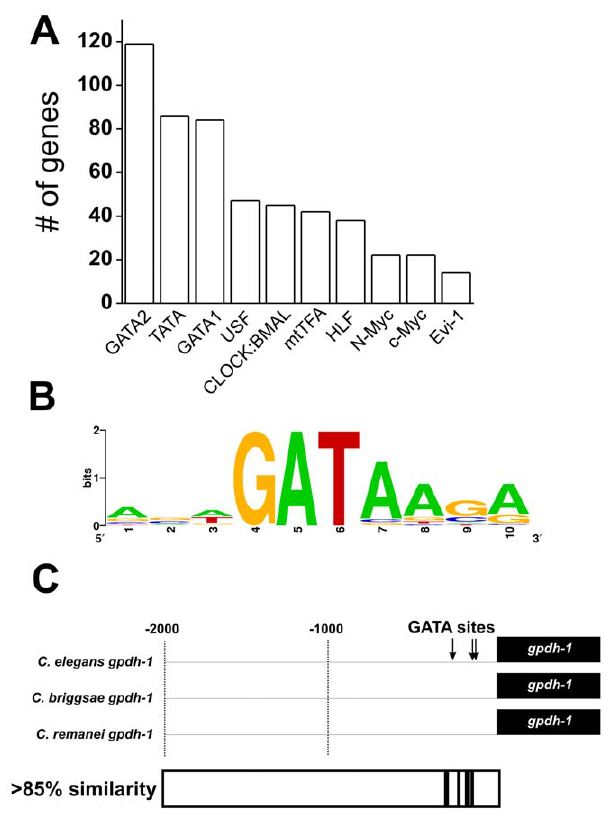
Figure 3. GATA transcription factor binding sites are over- represented among upregulated ORGs. (A) TRANSFAC-annotated transcription factor DNA binding motifs with enrichment scores . 1.5 and p-values , 0.05 in both C. elegans and C. briggsae ORGs. The number of ORGs with each motif is plotted. For details of enrichment analysis, see ‘Methods’. Only binding motifs with p-values of , 0.05 in both C. elegans and C. briggsae datasets are shown. GATA - GATA binding protein 2; TATA - TATA sequence binding protein; USF - Upstream stimulatory factor (USF1 and USF2); Clock:BMAL - brain-muscle-ARNT- like protein 2 (ARNT-2); mtTFA - mitochondrial transcription factor A; HLF - hepatic leukemia factor; N-Myc - neuroblastoma MYC oncogene; c-Myc - c-myc proto-oncogene; Evi-1 - Ecotropic viral integration site 1 transcription factor. (B) Consensus GATA2 motif from 181 occurrences in the C. elegans ORG dataset. (C) Analysis of the gpdh-1 promoter from C. elegans , C. briggsae , and C. remanei . Regions containing . 85% identify among all three promoters are indicated in black shading. gpdh-1p::GFP expression was robustly induced in the hypodermis and intestine of wild type animals following brief (4 h or 8 h) exposure to 200 mM NaCl (Figure 4B,C). RNAi inactivation of both osm-7 and osm-11 , which negatively regulate gpdh-1 expression [18], also resulted in robust GFP expression in the intestine and hypodermis under isotonic conditions (Figure 4D,E). In contrast, all D GATA- gpdh-1p::GFP transgenic lines failed to express significant levels of GFP even after 8 hours of exposure to 200 mM NaCl (Figure 4B,C). Genetic activation of D GATA - gpdh- 1p::GFP by inhibition of osm-7 and osm-11 was also strongly attenuated. Interestingly, in response to genetic activation, intestinal expression was completely eliminated in D GATA - gpdh- 1p::GFP , but hypodermal expression frequently persisted in both